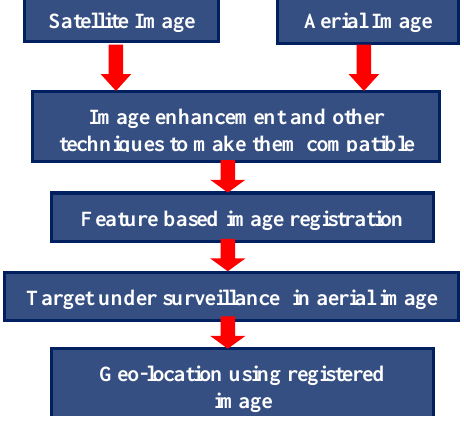
Figure 1. Geo-location module using Feature